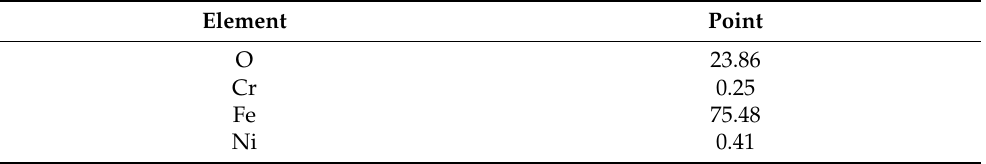
Table 4. Mass percentages of the different four elements in Figure 8 (wt.%).